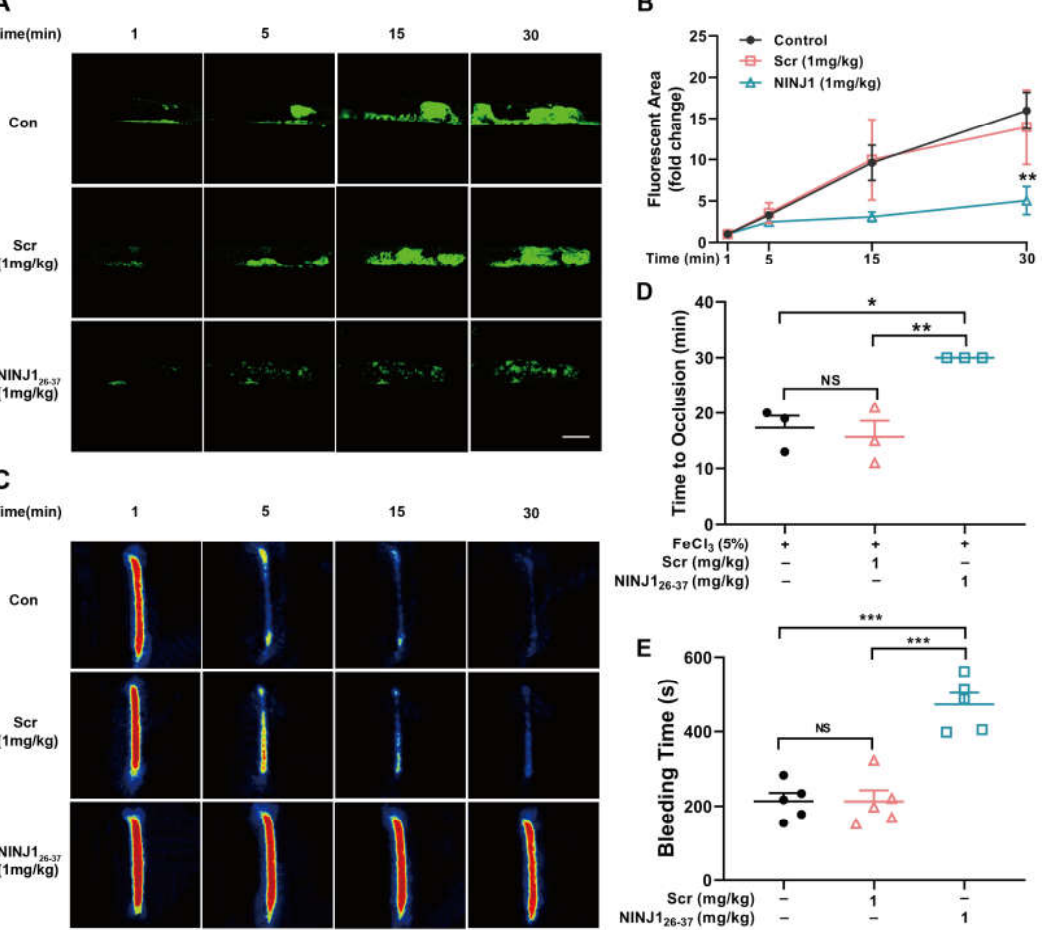
Figure 4. Inhibition of NINJ1 reduced FeCl3-induced arterial thrombosis. ( A ) The panel shows representative microphotographs of carotid artery thrombus (5% FeCl 3 injury) as visualized by upright intravital microscopy in male mice. Platelets were labeled in vitro with calcein ( n = 3). ( B ) The rate of thrombus growth was calculated by dividing the area of the thrombus at different times (5, 15, or 30 min) by the area of the same thrombus at the time (1 min). Values are mean ± SEM, * p < 0.05, ** p < 0.01, *** p < 0.001. Two-way ANOVA with Tukey’s multiple comparison test. ( C ) The panel shows a representative pseudo-color photograph of blood flow of carotid artery thrombus (5% FeCl 3 in- jury) observed with a laser speckle contrast imaging. The red color represents the high blood perfu- sion signal. Yellow represents a low blood flow perfusion signal. ( D ) The panel shows the time to occlusion ( n = 3). ( E ) Tail bleeding time was measured after the tip of the tail was removed 2 mm, values are mean ± SEM, n = 5. NS = p > 0.05, * p < 0.05, ** p < 0.01, *** p < 0.001. One-way ANOVA with Tukey’s multiple comparisons.